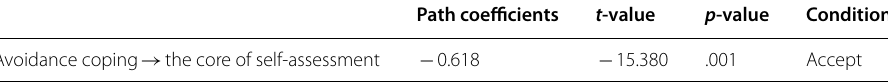
Significant at the level of 0.01 ( p < 0.01)